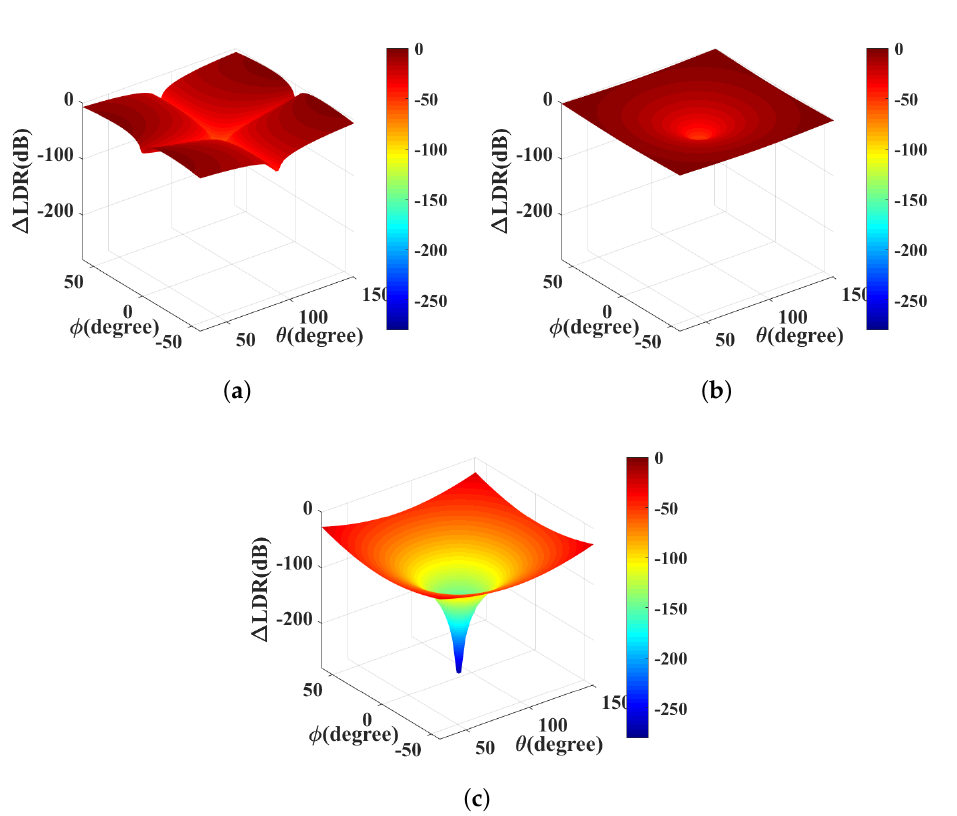
Figure 8. The bias of the differential reflectivity versus beam scanning angle. ( a ) LP wave; ( b ) CP wave; ( c ) EP